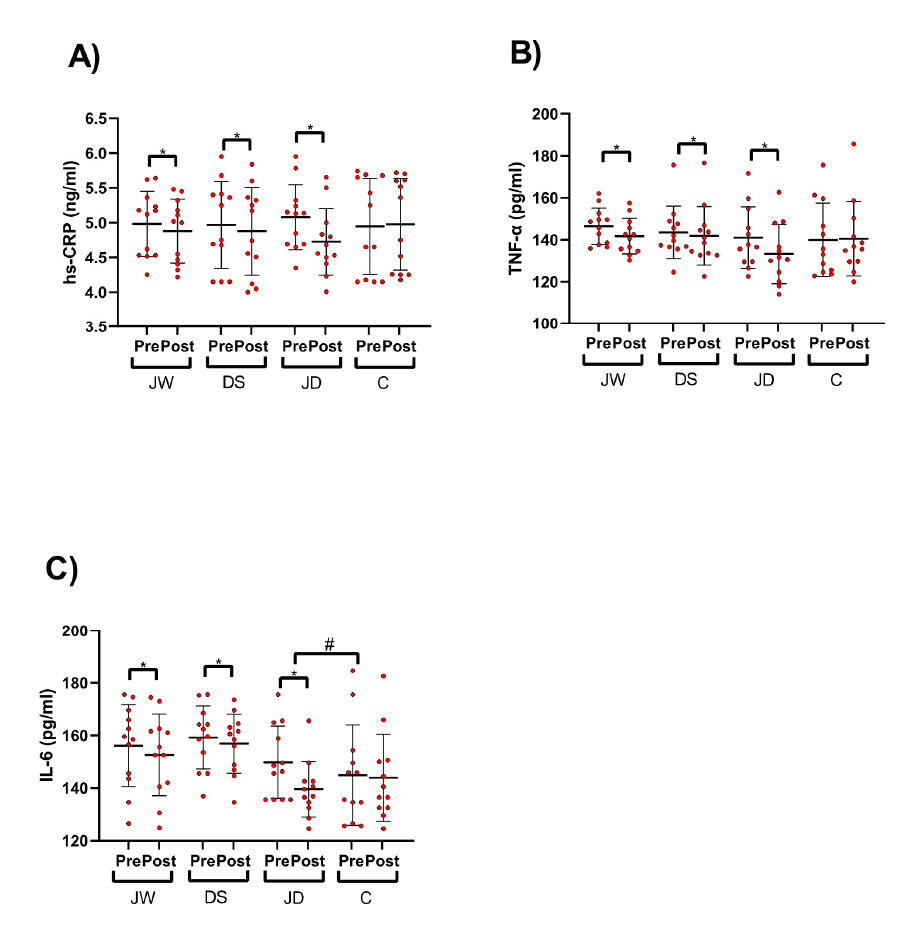
Figure 2. Pro-inflammatory cytokine concentrations. ( A ) high-sensitivity-reactive protein (hs-CRP), ( B ) tumor necrosis factor- α (TNF- α ), ( C ) Interleukin-6 (IL-6). * p < 0.05 different from pre-training; # between group difference.